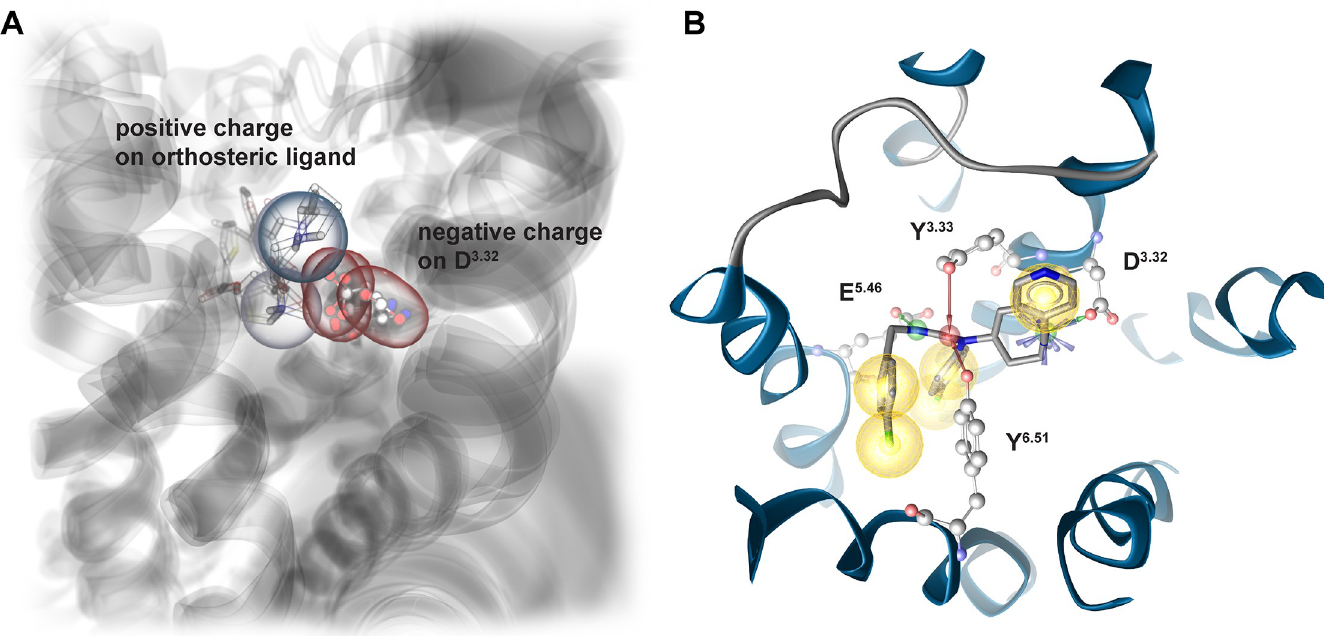
Fig 1. Ligand-guided homology modeling workflow exploits essential charged interaction known from aminergic GPCRs. (A) Aminergic GPCRs show a common charge interaction of highly diverse ligands with Aspartate 3.22 as illustrated for Eticlopride co-crystallized with the dopamine D3 receptor (3PBL [21]), Tiotropium co- crystallized with the muscarinic M 4 receptor (5DSG [22]) and Carazolol co-crystallized with the β 2 adrenoceptor (5JQH [23]). (B) Predominant binding mode of ligand series (Table C in S1 File) used for ligand-guided homology modeling. The depicted docking pose of CHEMBL1091834 involves a charged interaction with D 3.32 ¸ hydrogen bonds to D 3.32 , Y 3.33 , E 5.46 and Y 6.51 as well as several hydrophobic contacts. Red arrows–hydrogen bond acceptors, green arrows–hydrogen bond donors, blue star–positive ionizable, yellow sphere–hydrophobic